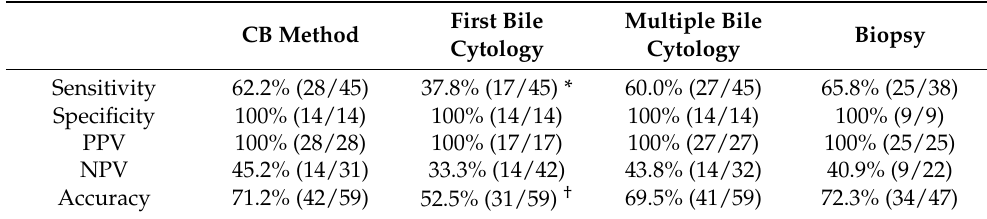
Table 3. Diagnostic efficacy of the cell block (CB) method, bile cytology, and biopsy.